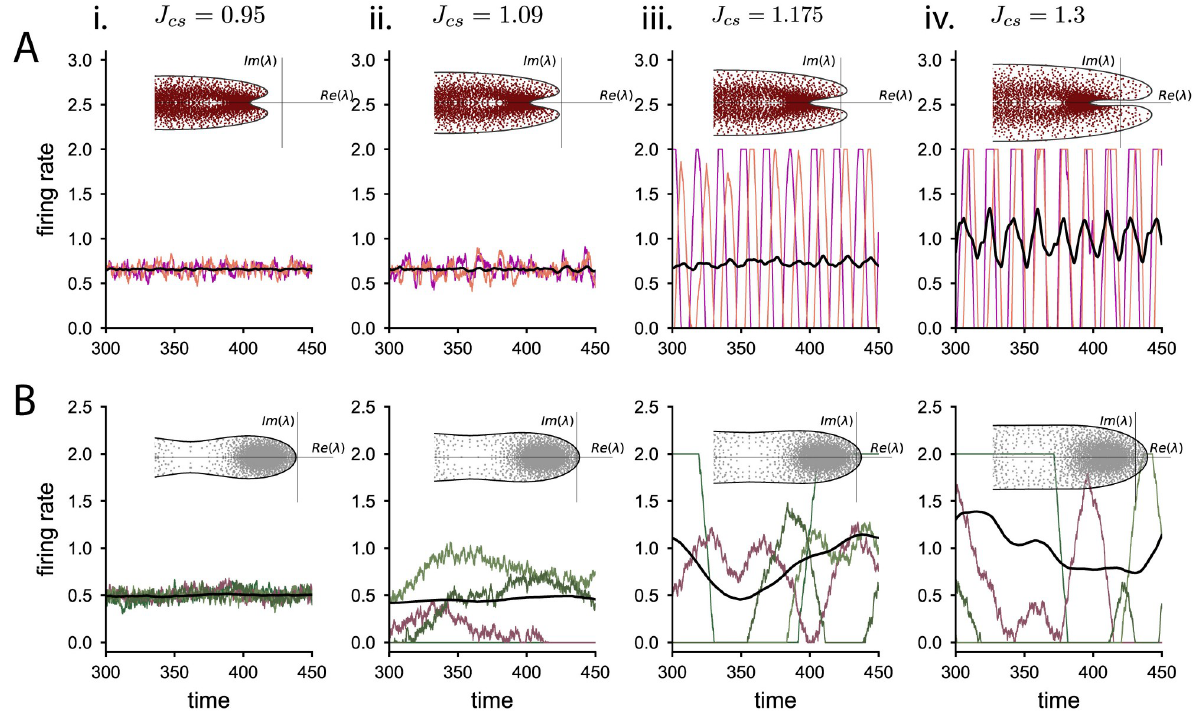
Fig 6. Dynamical regimes for the network with adaptation or synaptic filtering with additive external noise. Numerical integration of the dynamics with units receiving additive external white noise, as a proxy for spiking noise. A: Network with adaptive neurons. B: Network with synaptic filtering. Colored lines correspond to the firing rate of individual neurons, the black line indicates the population average activity. Insets: complex eigenspectrum λ of the dynamic matrix at the fixed point. Dots: eigenvalues of the connectivity matrix used in the network simulation. Solid line: w / s theoretical prediction for the envelope of the eigenspectrum. i. Both the network with adaptation and synaptic transmission are stable, the external noise generates stationary fluctuations around the fixed point. ii. The network with synaptic filtering undergoes a zero-frequency bifurcation. Noise adds fast temporal variability in the firing rates. The network with adaptation remains stable, and the fluctuations are larger in amplitude. iii. The network with adaptation undergoes a Hopf bifurcation. The firing rate activity combines the fast fluctuations produced by white noise and the chaotic activity with an oscillatory component. iv. The network with adaptation shows highly irregular activity, and strong effects due to the activation and saturation bounds of the transfer function. Parameters as in Fig 4, external noise σ η = 0.06.